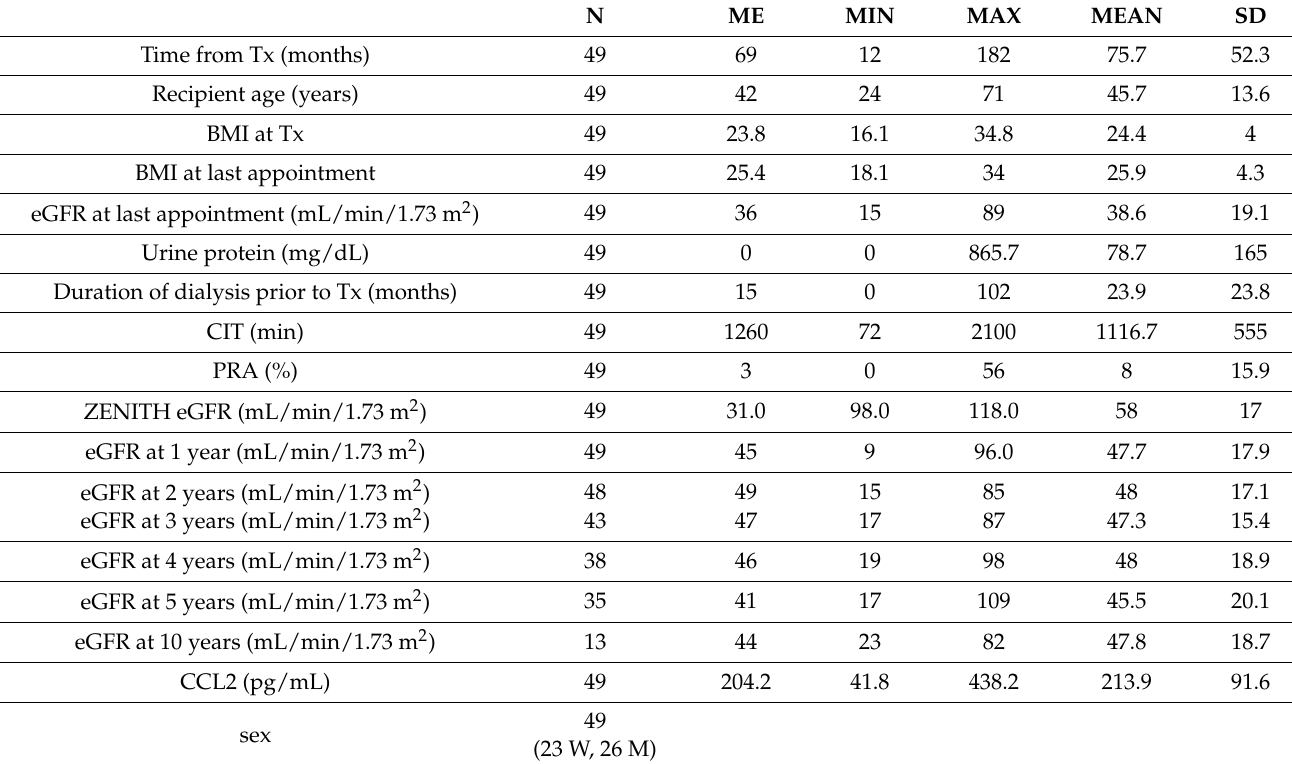
Table 4. Clinical characteristics of the study